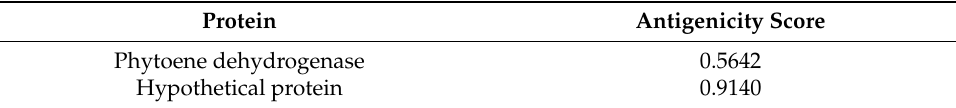
Table 1. Antigenicity score of the selected proteins using VaxiJen